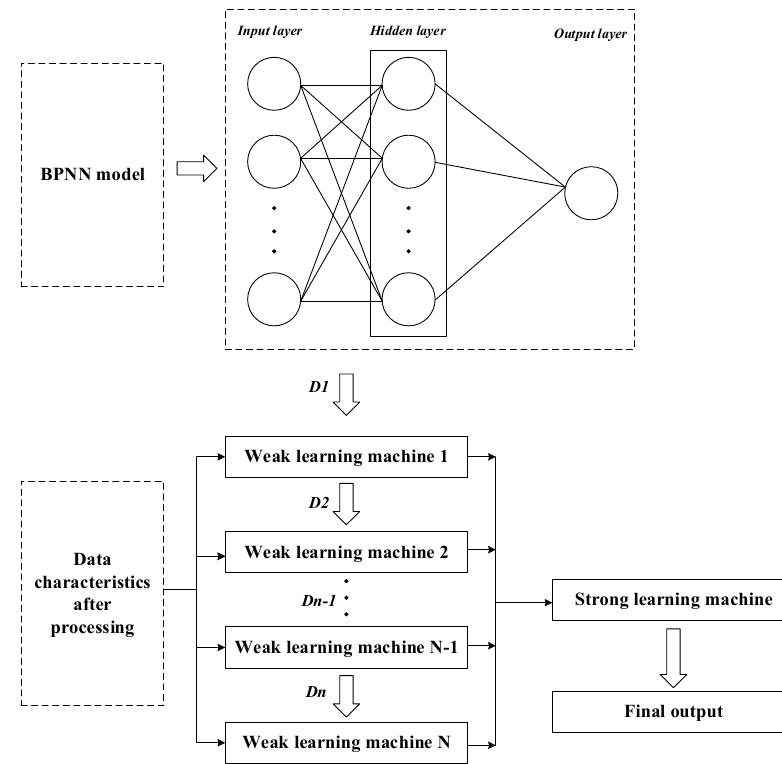
Figure 2. The calculating process of the AdaBoost-BP Algorithm.